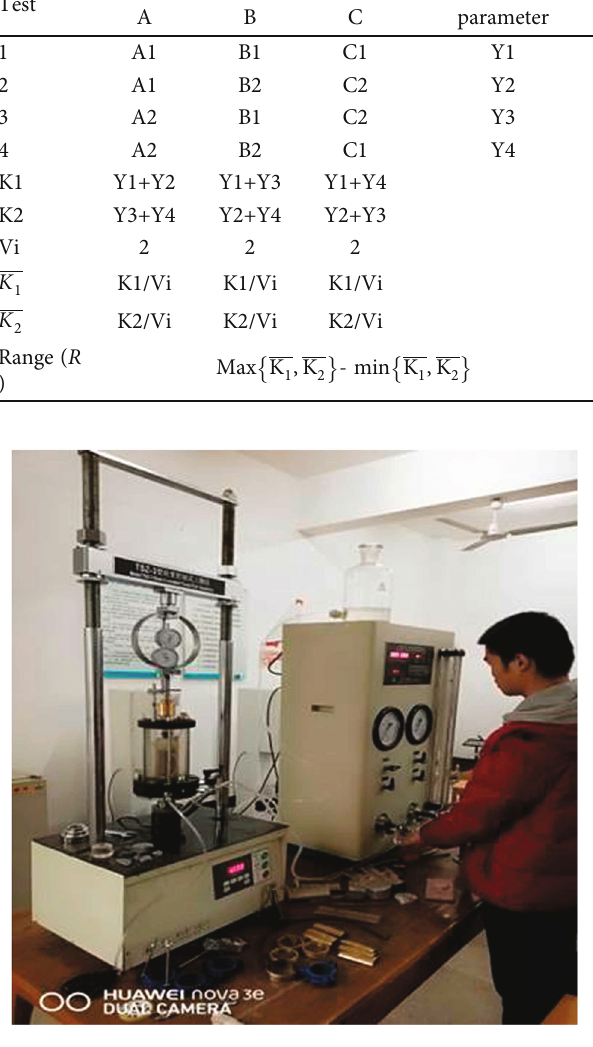
Figure 4: Triaxial